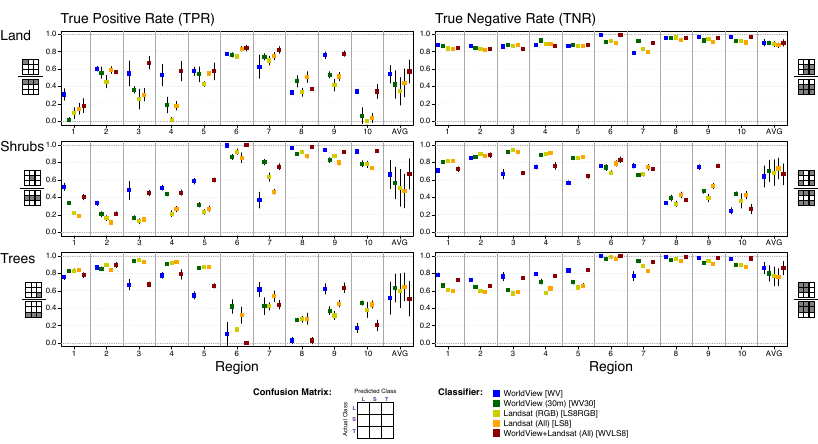
Figure 3. Performance metrics by class for five different combinations of spatial resolution and spectral bands from WorldView and Landsat. ( left column ) True Positive Rate (TPR) and ( right column ) True Negative Rate (TNR) are shown for land ( top row ), shrubs ( middle row ), and trees ( bottom row ). Metrics are provided for each of the ten study regions (Figure 2), along with the average across regions for each metric and classifier. (For each tile, error bars are the 95% Confidence Interval (CI) from the folds; per class are defined according to confusion matrix for a 3-class classification (representations modeled after [41]), shown at the bottom of the figure. We note that TNR is different from the 2-class classification case because it gets confused between the two negative classes. For this reason, we show TPR and TNR separately, and do not calculate the average between TPR and TNR (often referred to as balanced accuracy rate, or BAR). (A table version of these results can be found in the Appendix